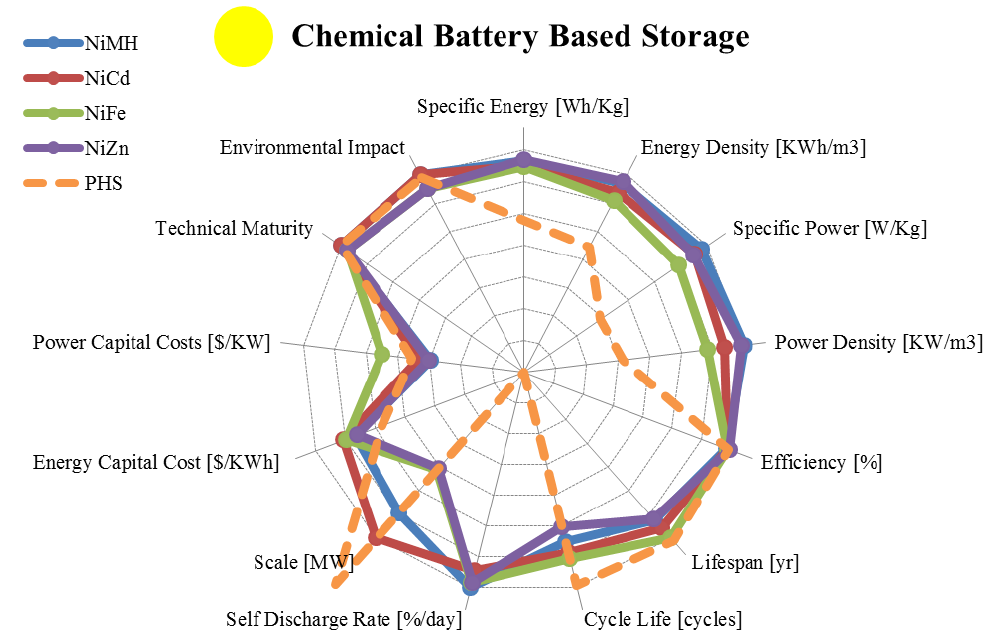
Figure 6. Comparing chemical energy storage in typically batteries using normalized and logarithmically plotted average data from Table